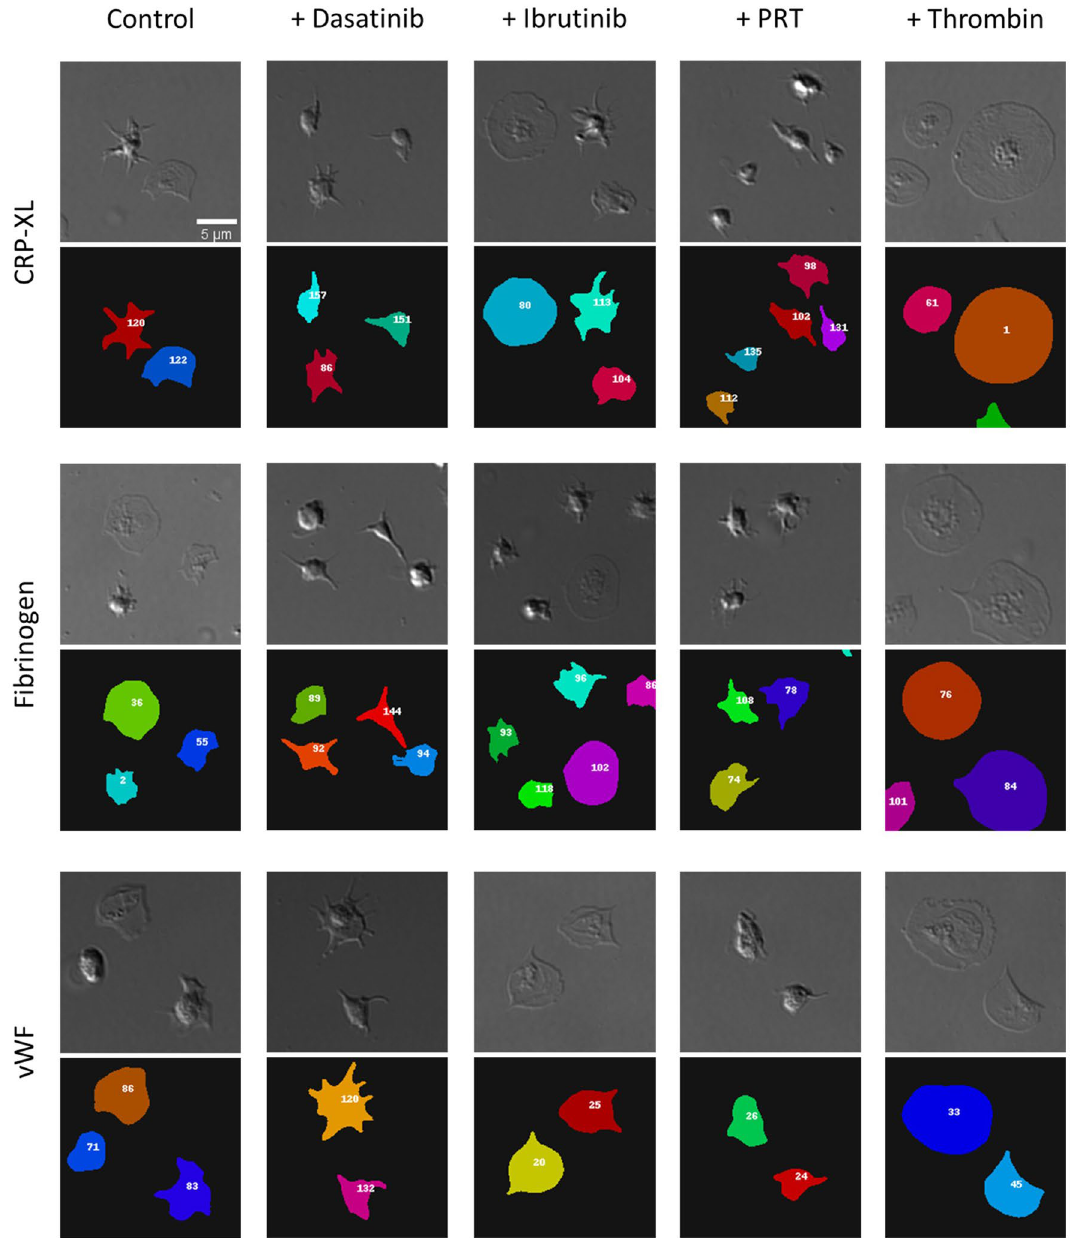
Figure 4. CNN can successfully identify inhibitor and agonist-induced changes in platelet morphology. Washed platelets (1 × 10 7 /mL) were spread over three different substrates (CRP-XL, fibrinogen or vWF) in the presence of either Dasatinib [10 μM], Ibrutinib [1 μM], or PRT-060318 [5 μM] inhibitor, thrombin [0.1 U/mL], or in the absence of inhibitor or agonist (control) to assess if the CNN could measure extremes in cell morphology. Representative cropped DIC images show the extremes in platelet cell shape, whilst corresponding segmented images demonstrate the cell morphology identified by the CNN. Scale bar represents 5 resulted in a significant decrease in platelet spread area when compared to control platelets spread on CRP-XL (38.52 ± 2.34 μm 2 ) (Fig. 5A). Dasatinib is an inhibitor of Src family kinases (SFKs) known to impair collagen- induced signalling 33,34 , whilst PRT-060318 is a Syk inhibitor previously shown to reduce platelet spreading over collagen 30,35 . Ibrutinib had no inhibitory effect on platelet spreading on CRP-XL (Fig. 5A), which is supported by studies which suggest that the kinase activity of Btk does not play a major role downstream of GPVI 27,33 . No further increase in spread area was found in the presence of thrombin, suggesting that control platelets were fully spread. When platelets were spread on fibrinogen the CNN identified that thrombin (43.31 ± 3.60 μm 2 ) resulted in a significant increase in platelet spread area when compared to control platelets (23.97 ± 3.94 μm 2 ) (Fig. 5B). This is a result of thrombin initiated integrin inside-out signalling, leading to enhanced activation and binding